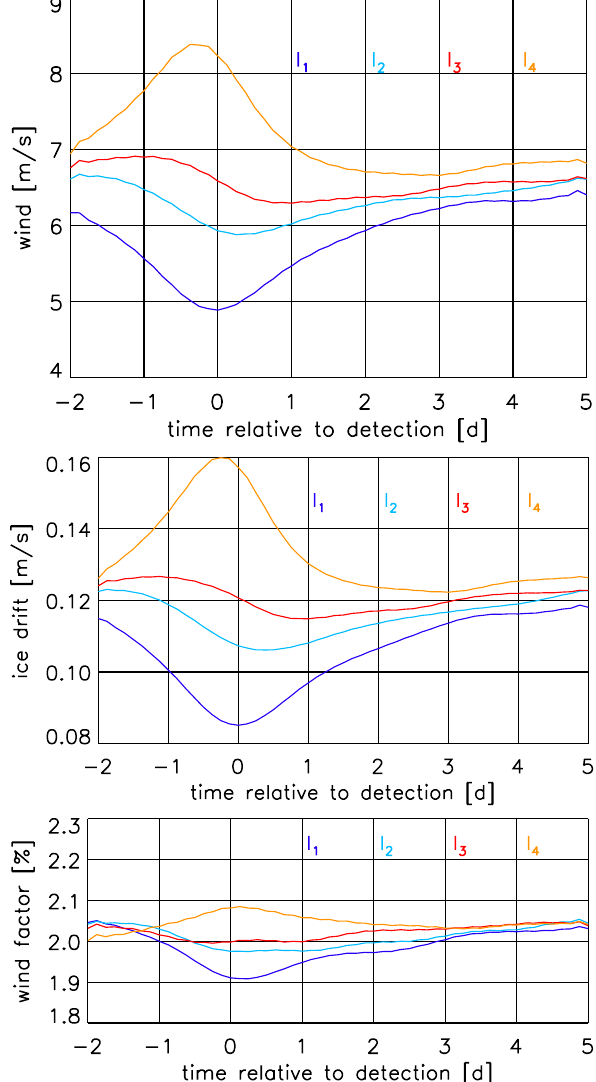
Fig. 4. Mean wind factor (top) and mean angle between wind forc- ing and ice drift (bottom) for the cyclone intensity classes I 1 to I 4 . Isoline interval is 0.2% for wind factor and 5 ◦ for deviation angle.